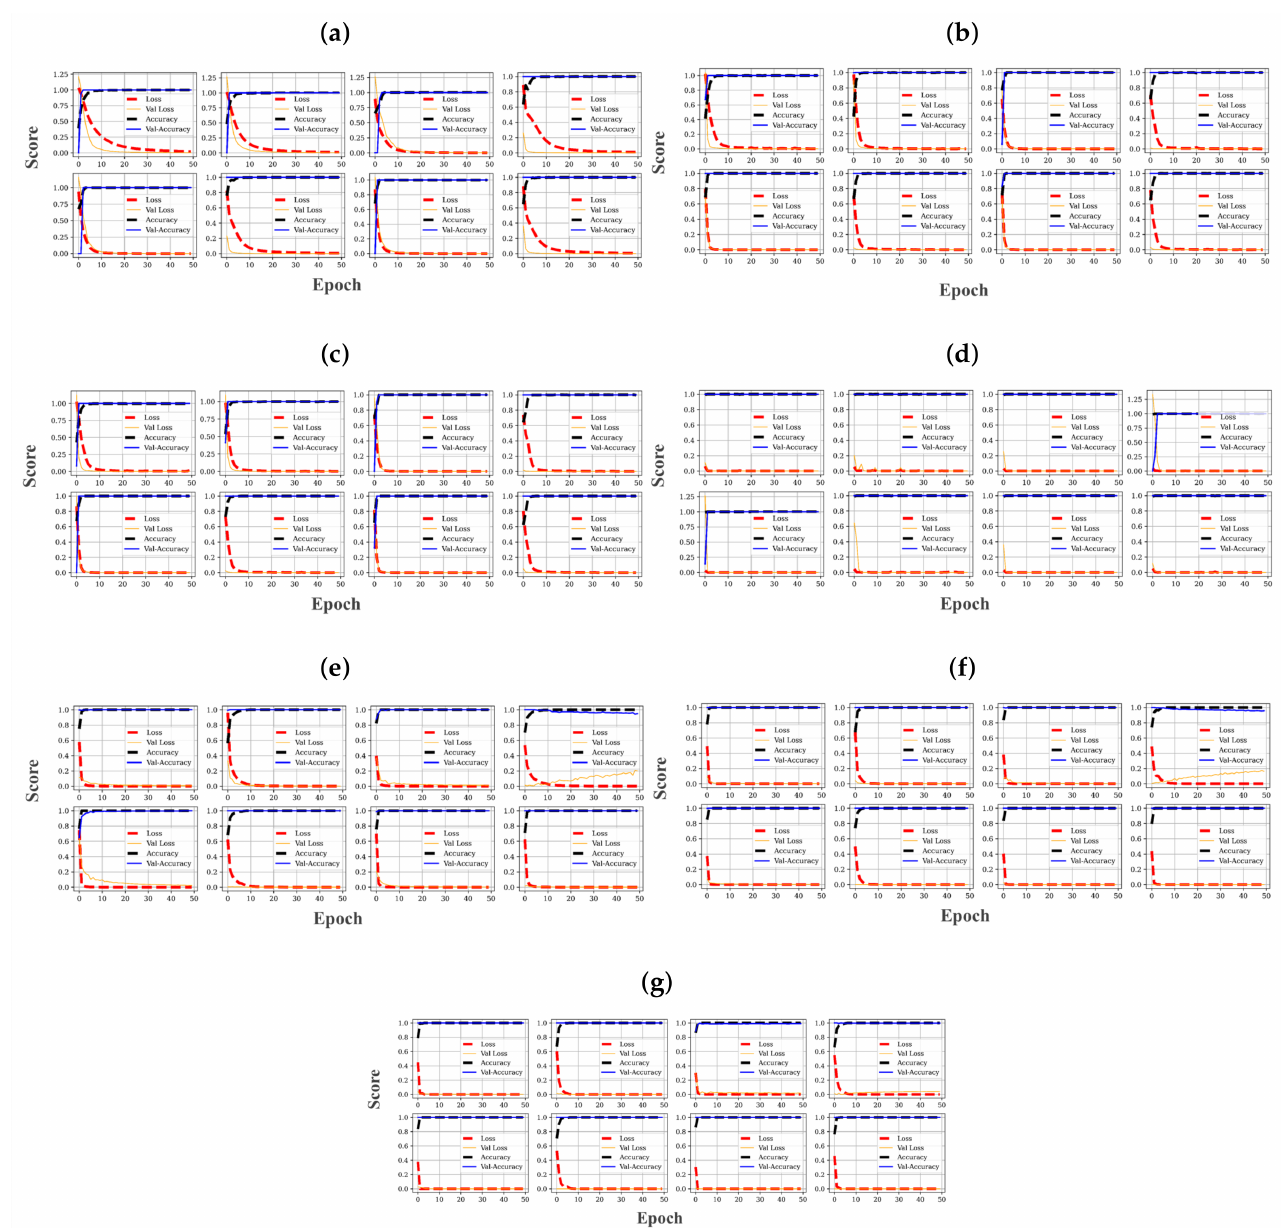
Figure 9. Training history for ( a ) CNN 64, ( b ) CNN 64_64, ( c ) CNN 64_Dense100, ( d ) FCN, ( e ) DNN64, ( f ) DNN128_64, and ( g ) DNN100_150_50. For each subfigure, the eight images respectively represent the training histories for the eight different input/source data channels in the order: SP R , SP C , FR R , SP C , SP _ FR R , SP _ FR C , SP R FR C , SP C FR R . As shown, the respective models have zero training and validation losses over the first few iterations (as shown in the red-dotted and yellow lines, respectively). These are also accompanied by a 100% training and validation accuracy from each of the models (as shown in the black-dotted and blue lines, respectively). These only validate that the models are quite efficient for learning the discriminative information stored in the training data and cannot form generalization criteria for assessing the models. Similarly, a test set was deployed for the models in an unsupervised manner, and their respective test scores were recorded. Table 2 provides the dimensions of the different input/source data channels and the test scores of the different models,